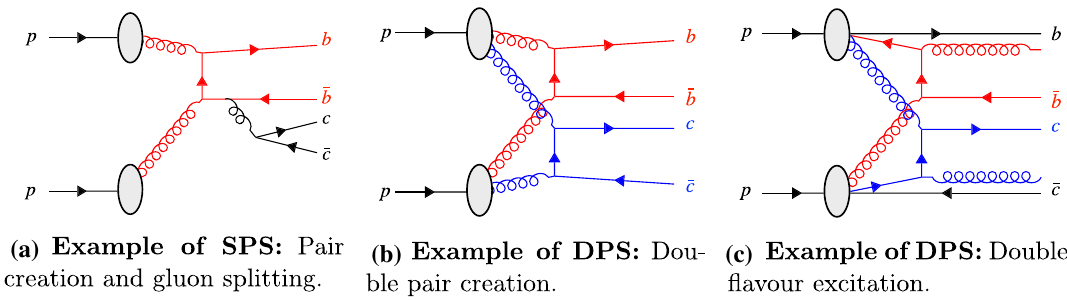
Fig. 3 Production mechanisms for events with both a b ¯ b and c ¯ c pair. The incoming, outgoing and intermediate particles of each parton– parton interaction are shown in red and (where relevant) blue. In the